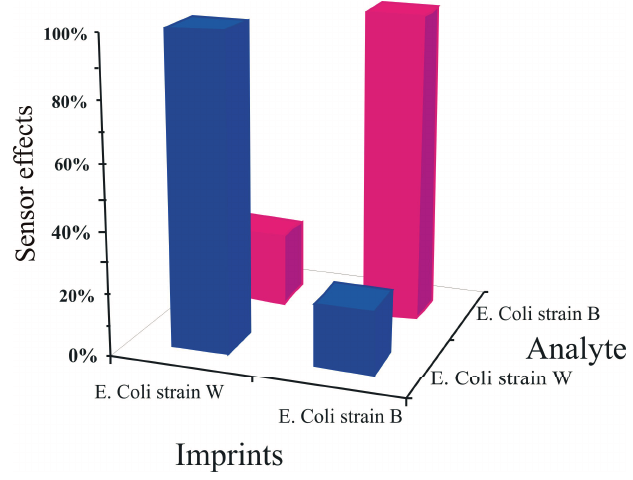
Figure 8. Cross sensitivity of a E. coli bacteria sensor, 10 MHz QCM coated with polyurethane and imprinted with synthetic E. coli W and B stamps sensitive to strain W, and strain B, respectively. E. coli B and W having a concentration of 5 mg/mL in water were measured while exposing to different sensors at room temperature.